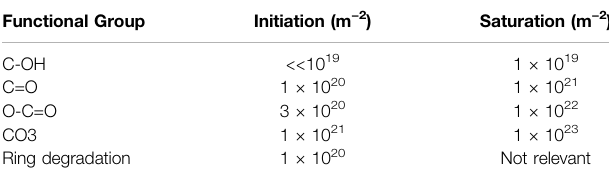
TABLE 1 | Approximate fl uences of neutral oxygen atoms in the ground state useful for the initiation of the functionalization of polystyrene with speci fi c functional groups and saturation with the groups. The values were determined at room